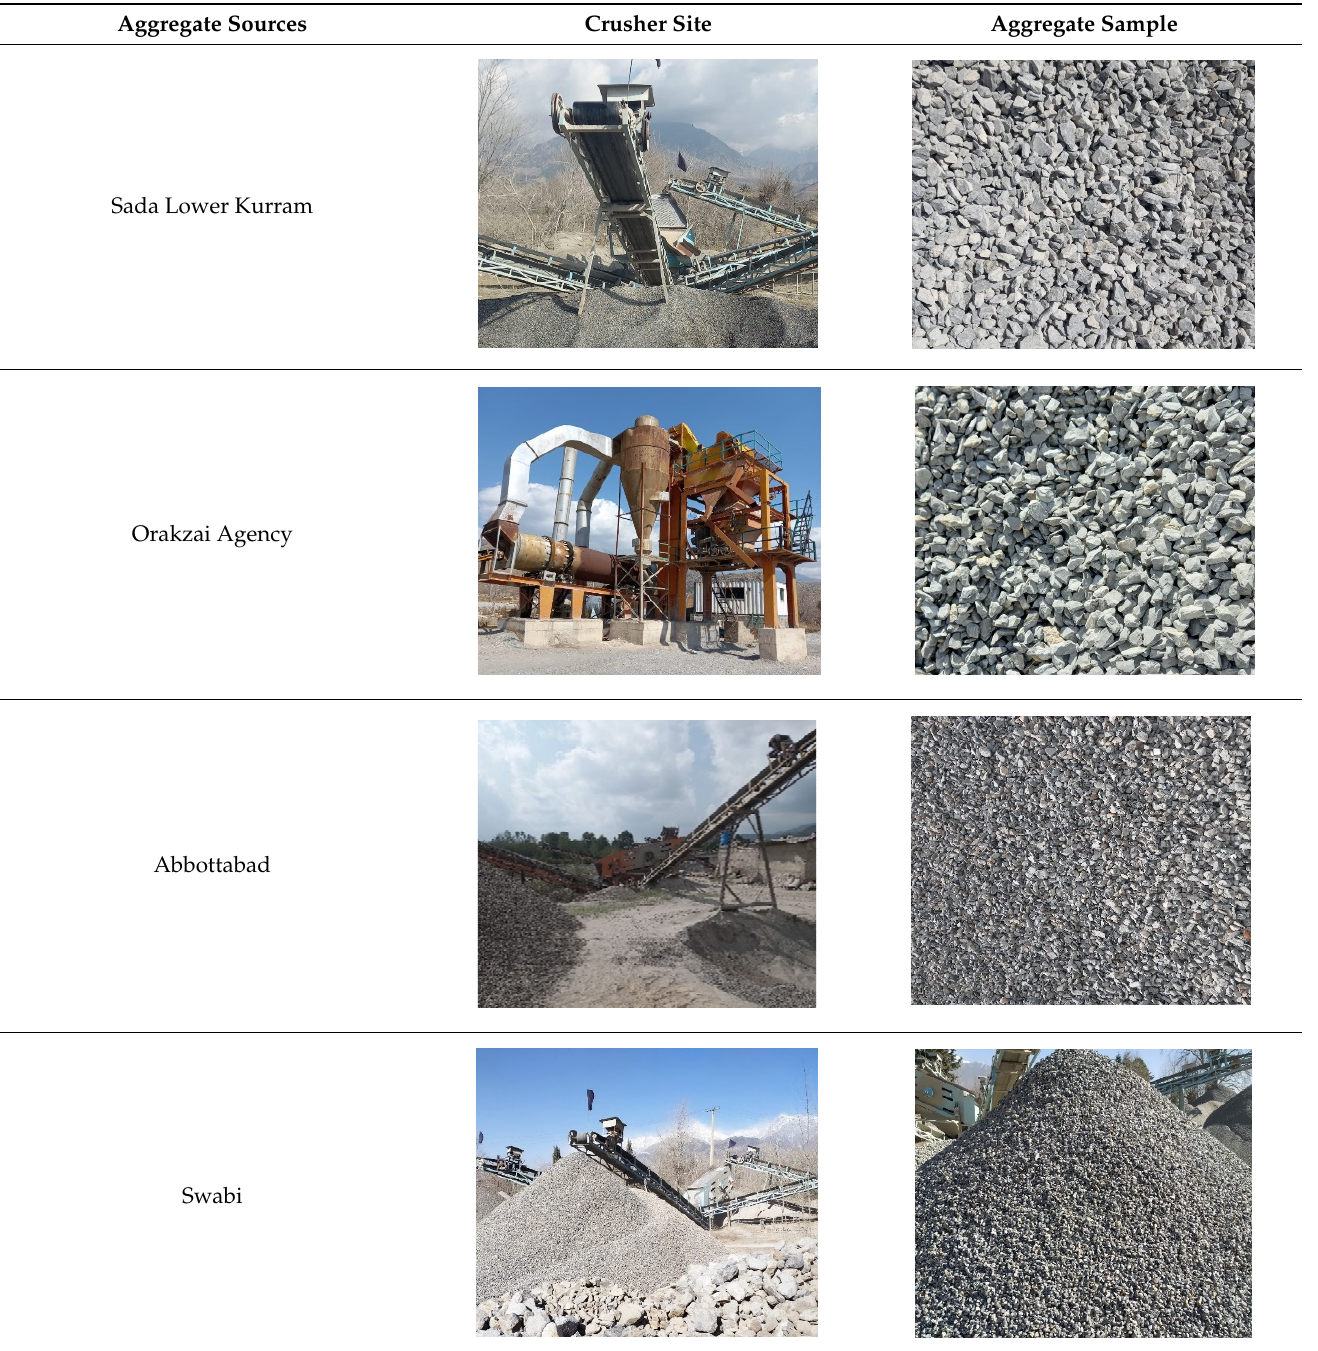
Figure 1. Location of current study aggregates in comparison with aggregates reported in previous studies. 3. Experimental Procedures